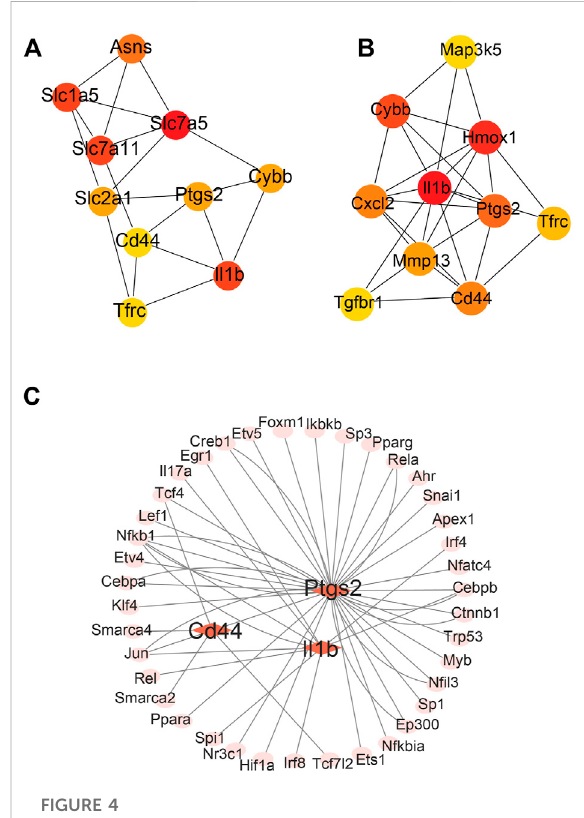
FIGURE 4 Major protein – protein interaction (PPI) networks and predicted transcription factors (TFs) of FRGs. (A) The major PPI network analysis of FRGs 2 days after ligation. (B) The major PPI network analysis of FRGs at 14 days after ligation. The color gradation represents the expression; red represents a higher expression. (C) The prediction of mouse DEGs